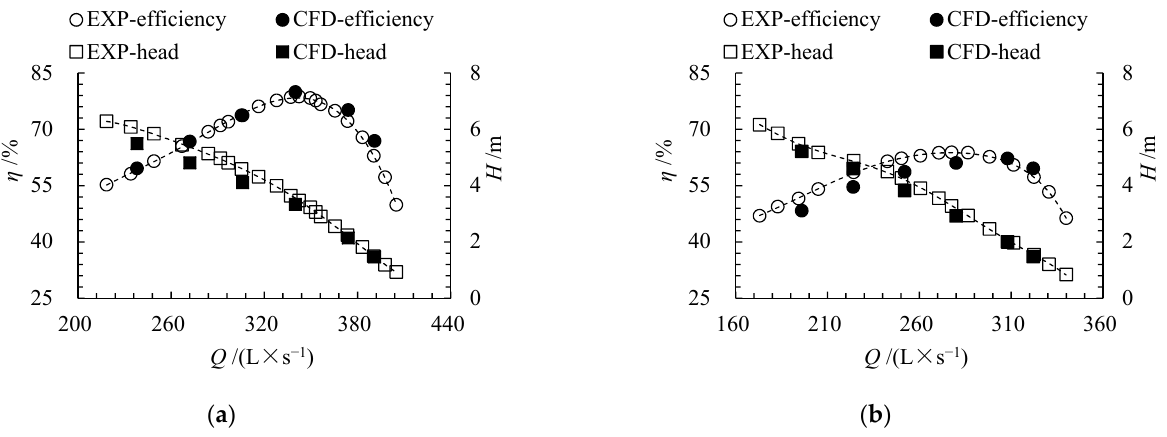
Figure 9. Comparison of CFD and experiment (EXP) results of original case under ( a ) forward and ( b ) reverse condition.